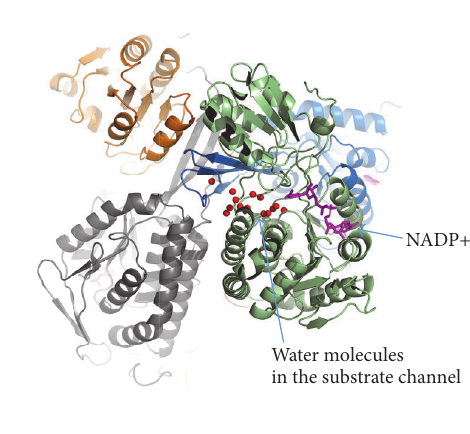
Figure 7: A putative substrate channel. The subunits that form the tetramer are shown in blue, grey, brown, and light green. The coenzyme is in magenta. The water molecules in the substrate channel are shown as red